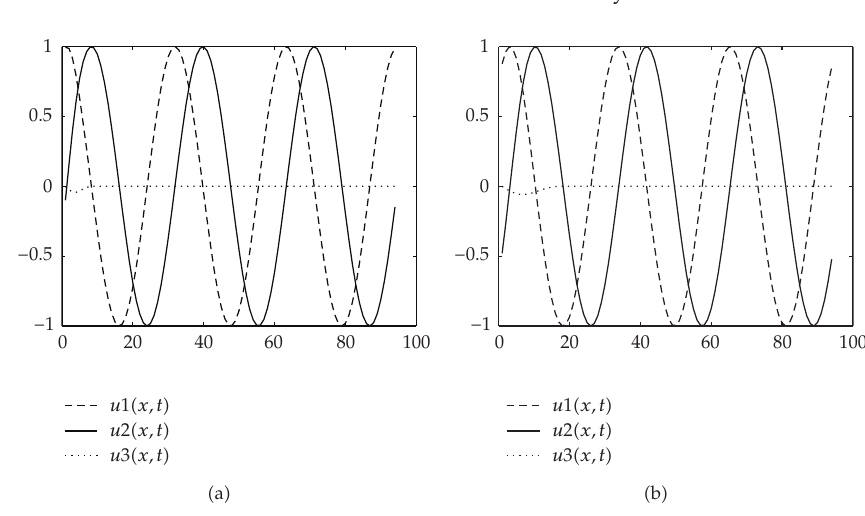
Figure 1: The solution u at (cid:3) a (cid:4) t (cid:7) 0 . 1, and (cid:3) b (cid:4) t (cid:7) 0 . 5; k (cid:7) 0 . 0001 ,h (cid:7) 1 / 5.